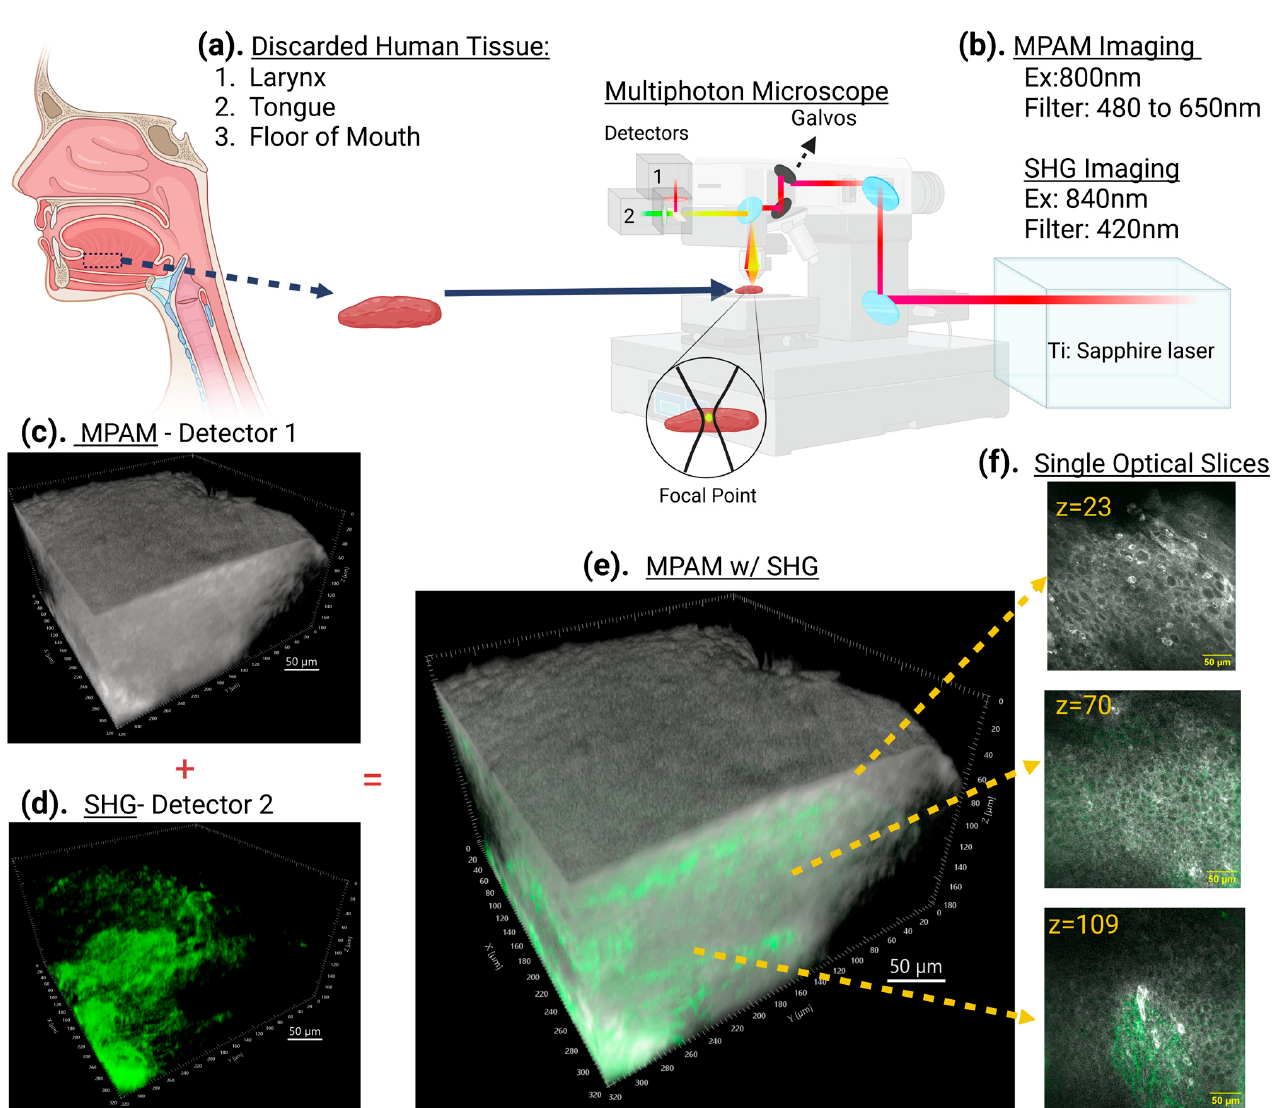
Figure 1. Schematic of MPAM and SHG imaging of resected head and neck human tumors. Multiphoton microscopy uses short femtosecond pulses of near infrared light to produce fluorescence in the visible region of the light spectrum in a laser scanning microscope configuration. Fluorescence excitation and, thus, emission are restricting to the objective focal point and scanning the laser in three-dimensions results in a 3D microscopy. When applied to unstained tissue, the source of fluorescence contrast is from intrinsic fluorophores in tissues. The workflow for imaging in this study was as follows: ( a ) discarded human tissue from tumors obtained from the larynx, tongue, or FOM were ( b , c ) imaged using 800 nm excitation for MPAM (pseudo colored in gray) and ( d ) 840 nm excitation for SHG from collagen (pseudo colored in green). The combination of these two z-stacks ( e ) provides a volumetric view of a region of interest on the collected sample. Optical sectioning of single slices at different depths ( f ) provides detailed observation at each depth, such as in these micrographs showing epithelial cells (round structures with a dark nucleus and bright autofluorescent cytosol) and collagen (green). Scale bar: 50 µm.